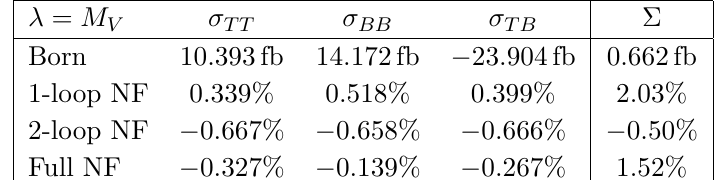
Table 1. Fiducial cross section for vector-boson fusion di-Higgs production at 13 TeV under the cuts of section 3.1. The (cid:12)rst row indicates the Born contribution in femtobarn of the triangle diagrams, box diagrams and their interference. The second row shows the 1-loop squared non-factorisable (1-loop NF) correction in percent of the Born results for the same three contributions. The third row shows the same but for the 2-loop times tree-level non-factorisable (2-loop NF) contribution. The last row shows the same breakdown but for the sum of both contributions. The last column shows the sum of the contributions across each row.